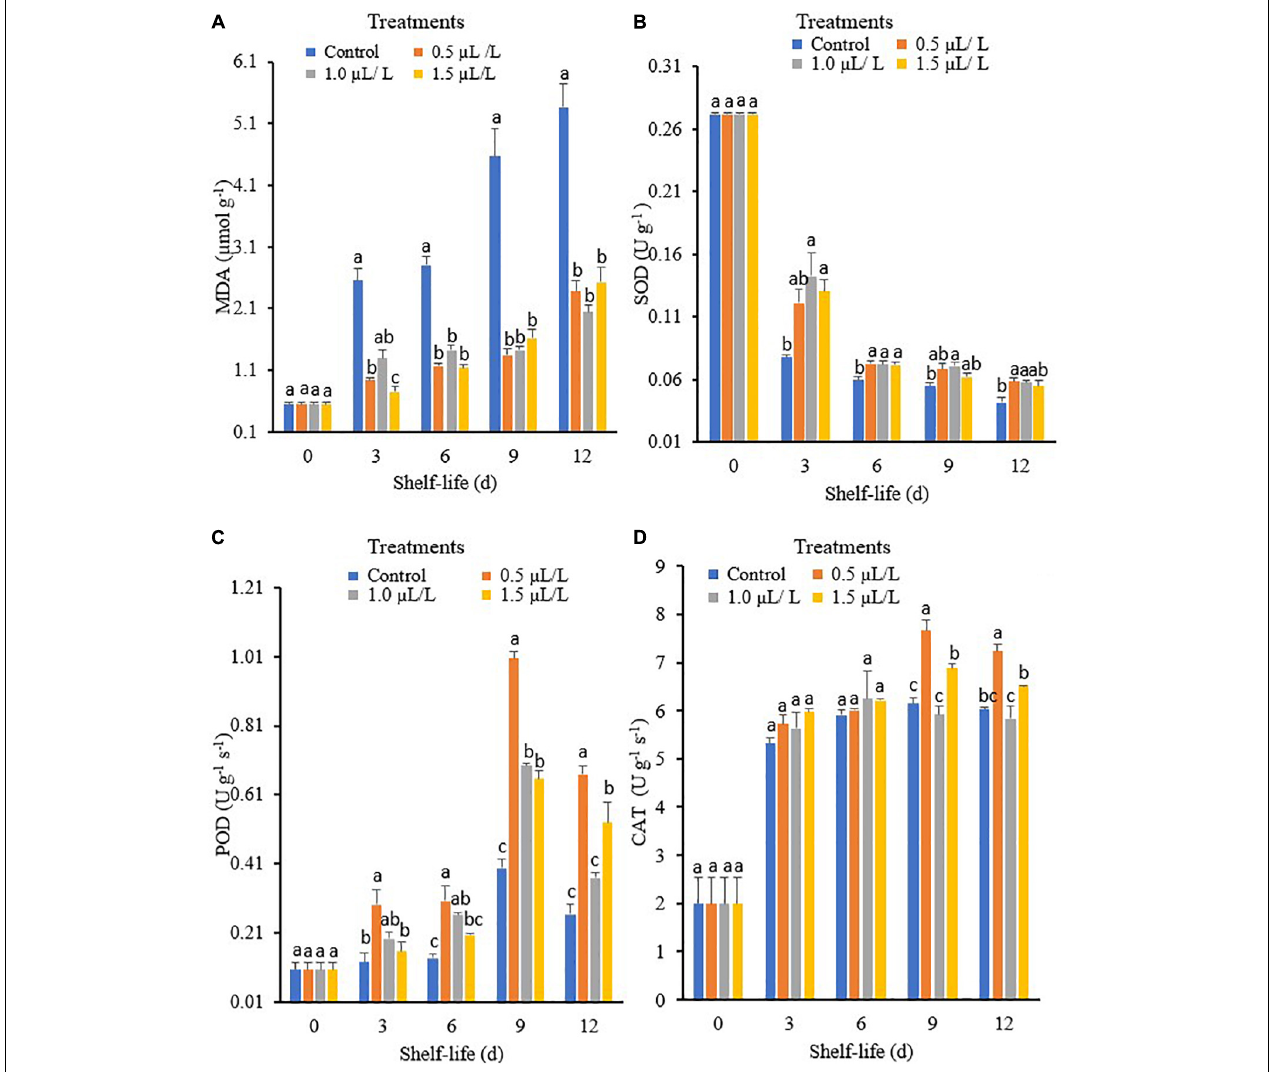
FIGURE 1 | Malondialdehyde (MDA) (A) , superoxide dismutase (SOD) (B) , peroxidase (POD) (C) , and catalase (CAT) (D) of green mature “Hangjiao No.2” chili peppers treated with different concentrations of 1-methyl cyclopropane (1-MCP) and the control during 12 days storage at ambient temperature. Each value is the mean of five replicates and each bar represents ± standard